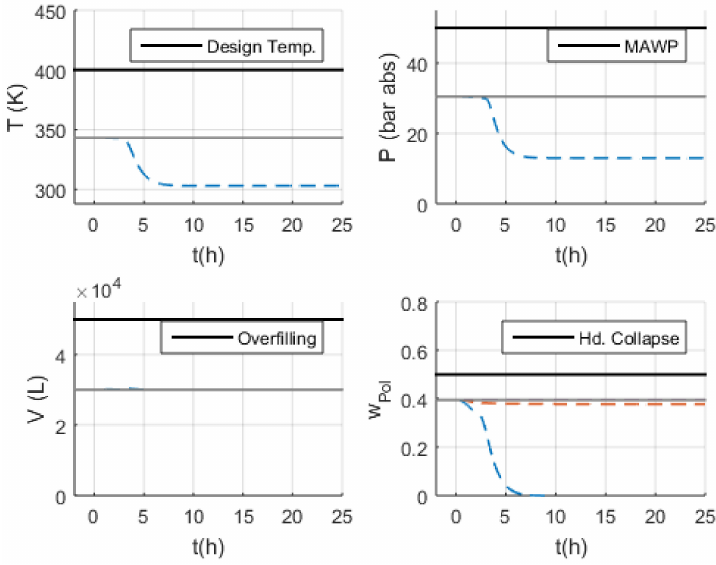
Figure 22. Behavior of critical variables in scenarios S-13 and S-14 with Model 2. Inlet TEA